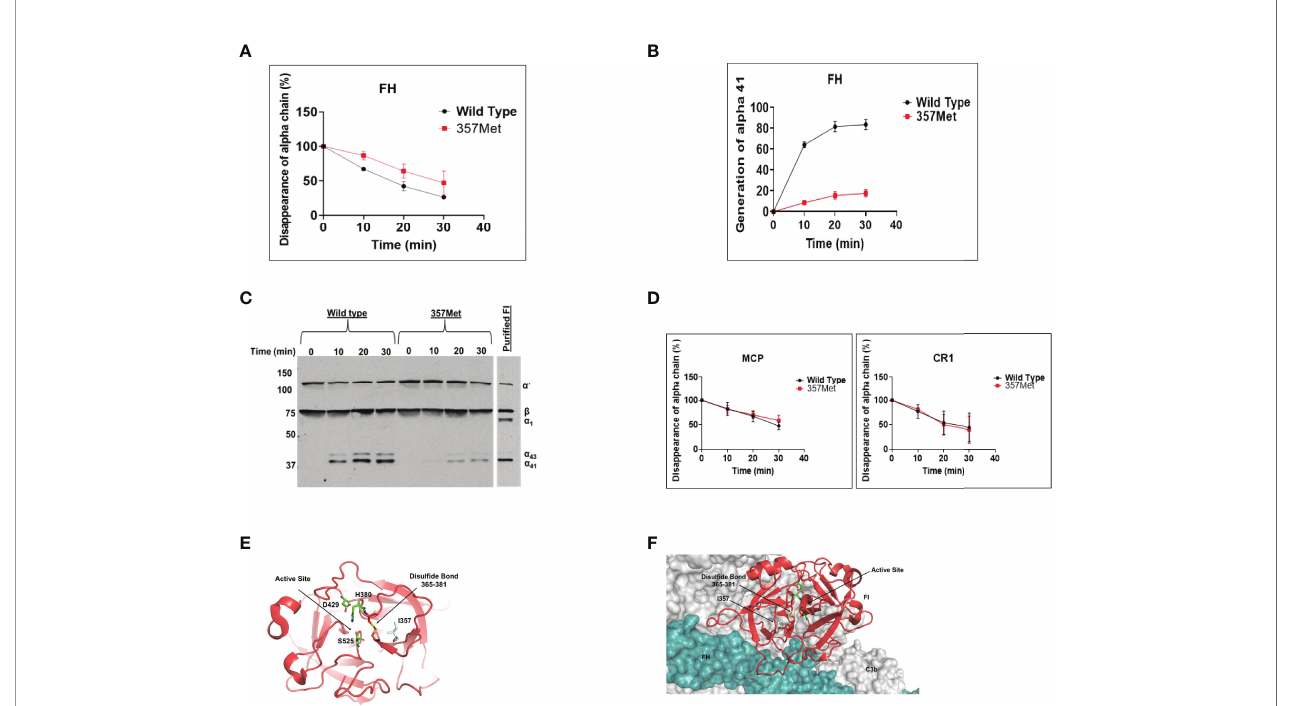
FIGURE 3 | Functional evaluation of Factor I (FI) variant Ile357Met: proteolytic activity. The fl uid-phase C3b proteolytic activity of the variant factor I (357Met) with its cofactor proteins (Factor H [FH], membrane cofactor protein [MCP], or complement receptor 1 [CR1]) was assessed by cleavage of puri fi ed C3b to iC3b and compared to wild type (WT). For these assays, puri fi ed WT and FI variant proteins were diluted in physiologic salt (150 mM NaCl) buffer with C3b (10 ng; Complement Technologies, Inc, Tyler, TX USA) at 37°C. Concentrations of WT or variant FI used with the individual cofactors were 10 ng with MCP, 20 ng with FH and 15 ng with CR1. Concentration of cofactor used in the reactions were 100 ng MCP, 200 ng FH or 150 ng CR1. Reactions were carried out in a total volume of 15 µl/reaction at 37°C. Kinetic analysis of the WT and variants was achieved through collection of sample at 0, 10, 20 and 30 min. At each time point 7 µl of 3x Laemmli reducing sample buffer was added to individual reactions to stop the reaction and then heated at 95°C for 5 min. The samples were electrophoresed on 10% Tris-glycine gel and then transferred to nitrocellulose for WB analysis. Membranes were rinsed with TBS-T (0.05%Tween-20) for 5 min and blocked overnight with 5% nonfat dry milk in PBS. Blots were probed with a 1:5,000 dilution of goat anti-human C3 (Complement Technologies, Inc, Tyler, TX, USA) followed by HRP- conjugated rabbit anti-goat IgG and developed with SuperSignal substrate (Thermo Fisher Scienti fi c, Waltham, MA, USA). The signal detected on radiographic fi lms was scanned using a laser densitometer (Pharmacia LKB Biotechnology, Piscataway, NJ, USA). Multiple exposures were used to establish linearity. (A, B) . The percentage of a ’ chain remaining and generation of a 41 fragment indicates cleavage of C3b to iC3b. Cleavage rate was measured by densitometric analysis of the a ’ chain remaining as well as generation of a 41 relative to the b chain. Data represent 2 separate experiments with bars corresponding to the standard error of mean (SEM). Upon comparison to WT FI, the proteolytic activity of variant 357Met was defective with FH. The P value for the difference in the percentage of a ’ chain remaining between WT and variant was 0.05 and for the difference in the percentage of a 41 generation was <0.05. (C). Representative WB demonstrating cofactor activity of Factor H with the variant (357Met) compared with wild type FI as well as puri fi ed FI (D) No defect was observed with MCP or CR1 as the cofactor protein. I, isoleucine; M, methionine. Structural evaluation of Ile357Met (E) Mapping of Ile357 on the structure of FI shows that it is located in the serine protease domain of FI which harbors the catalytic activity. Although the variant is away from the catalytic serine (S525)), the substitution of I to a bulkier amino acid M likely alters the position of the disul fi de bond 365-381, thus affecting the FI activity. (F) Mapping of the Ile357 on the triple complex of Factor H and C3b shows that the variant is away from the binding surface of FH, therefore we speculate that it likely leads to a conformational change resulting in low functional